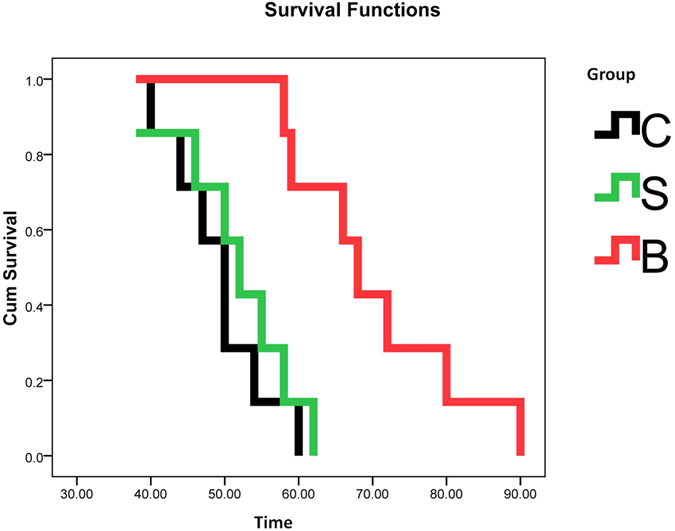
Survival curves.FBBAL treatment significantly prolonged the survival time. Survival time for group B, 70.4 ± 11.5 h; group S, 51.6 ± 7.9 h; and group C, 51.6 ± 7.9 h. B group vs. S group, P < 0.01. B group vs. C group, P < 0.01. S group vs. C group, P = 0.637.